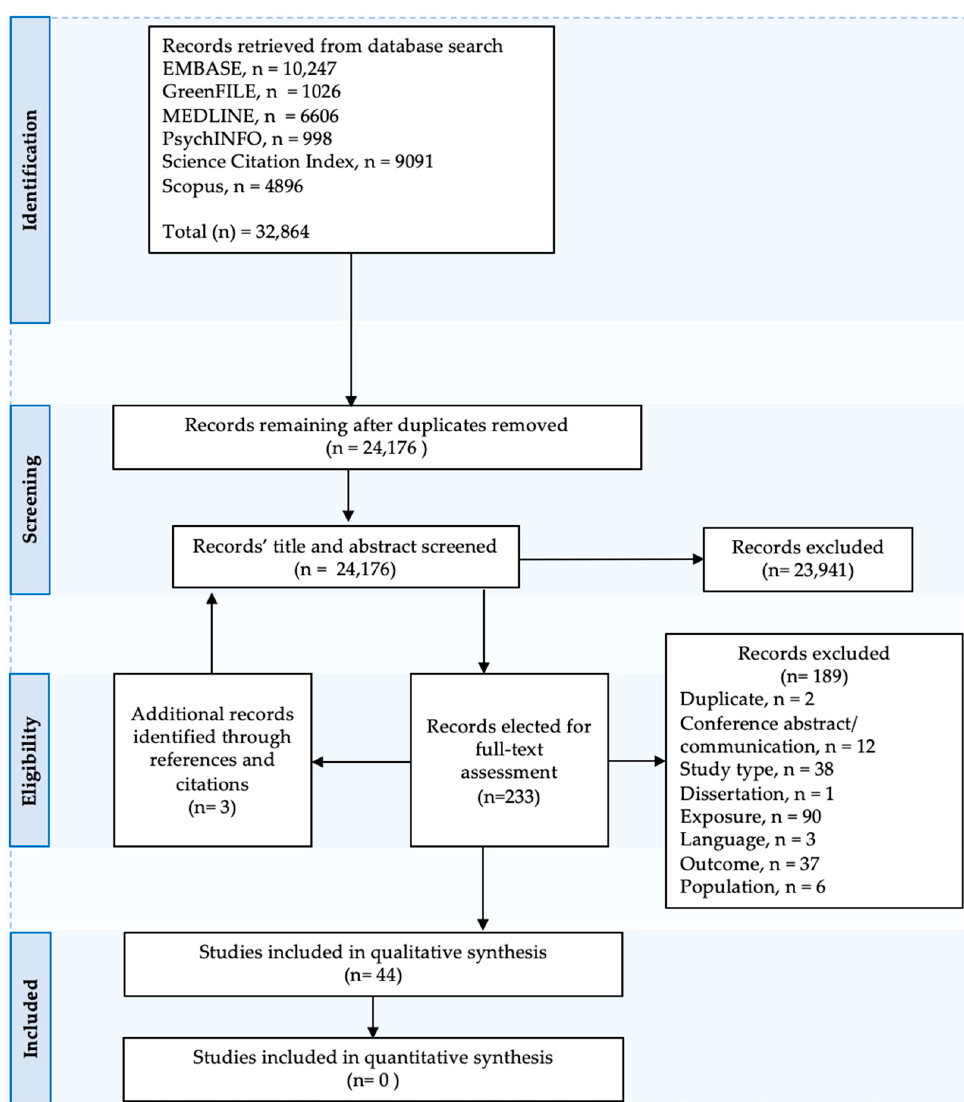
Figure 1. PRISMA-P Flowchart.